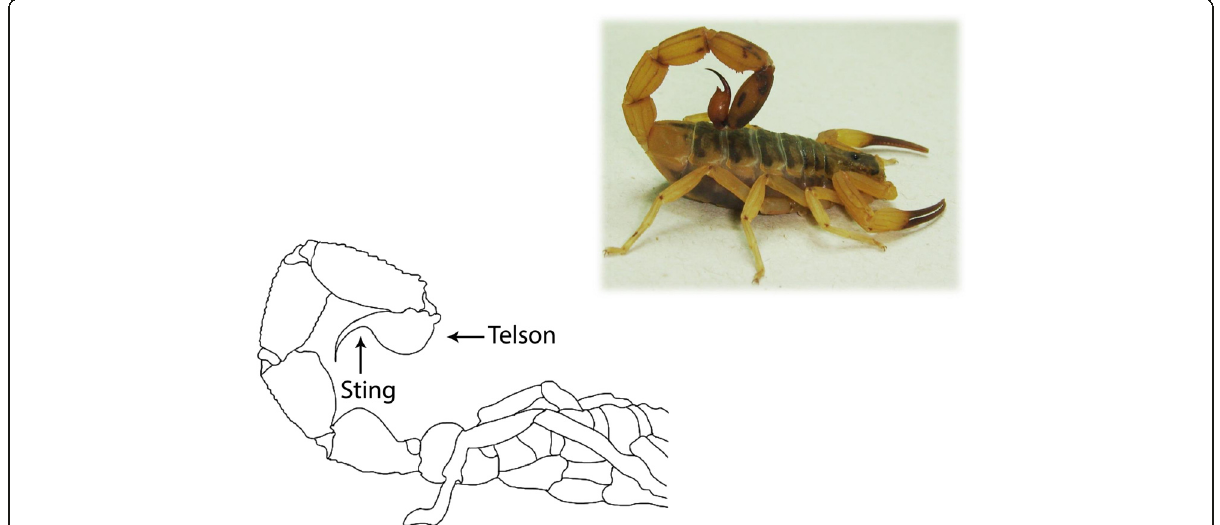
Fig. 2 Photo of a scorpion and schematic representation of scorpions ’ telson. Morphology of the inoculum apparatus of scorpion venom located on the last segment of the post-abdomen of the animal. The telson comprises a pair of glands responsible for the production and storage of the venom used for feeding and self-defense of the